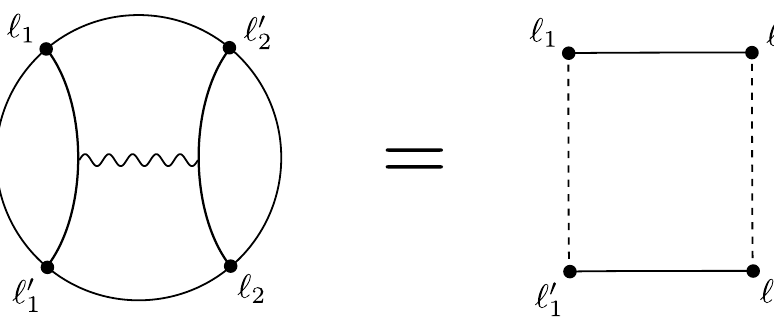
Figure 3 . Bulk and boundary diagrams for the correlator of two boundary bilocals. On the left, each bilocal is represented in the bulk by a Didenko-Vasiliev solution. The solid lines represent each solution’s central geodesic “worldline”, where its Fronsdal curvature is concentrated. The wavy line represents the multiplet of HS gauge fields exchanged between the two worldlines. On the right, each bilocal is represented by a dashed line, while the solid lines represent propagators (2.31) of the fundamental boundary fields χ I , ¯ χ . Upon restricting to even spins, one should average the I boundary diagram under ‘ 0 1 ↔ ‘ 1